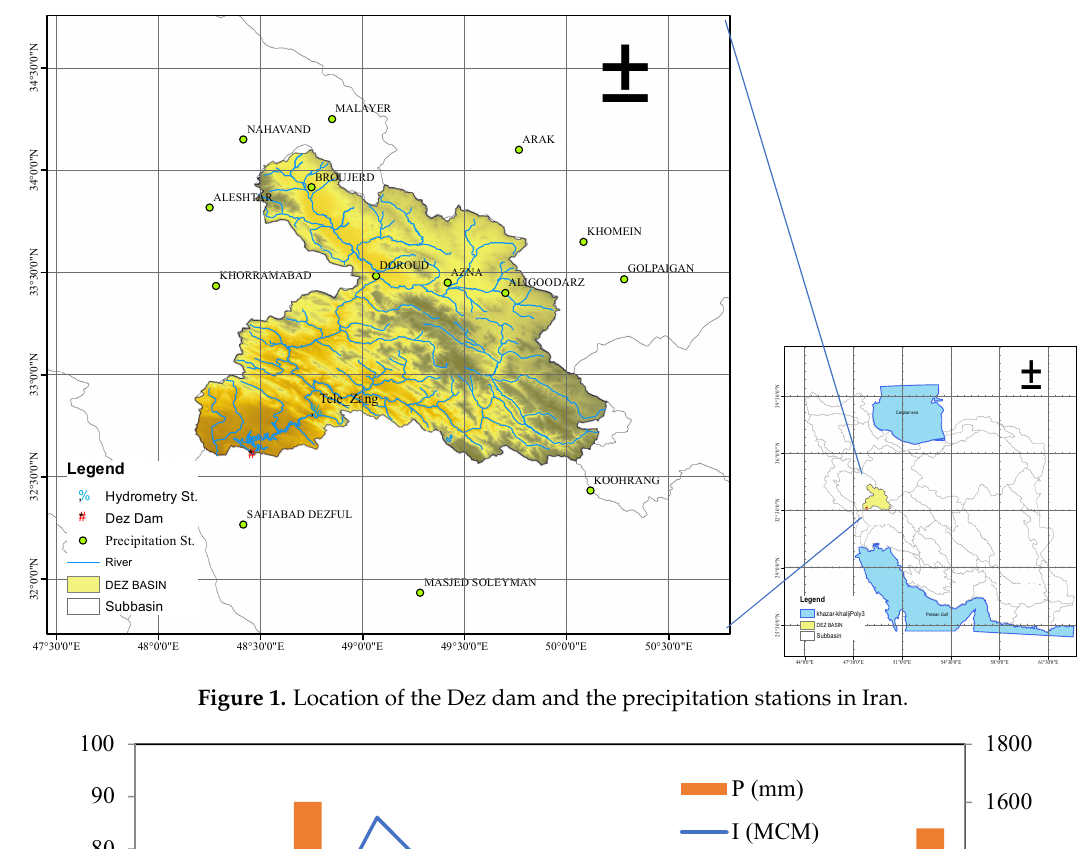
Figure 1. Location of the Dez dam and the precipitation stations in Iran.